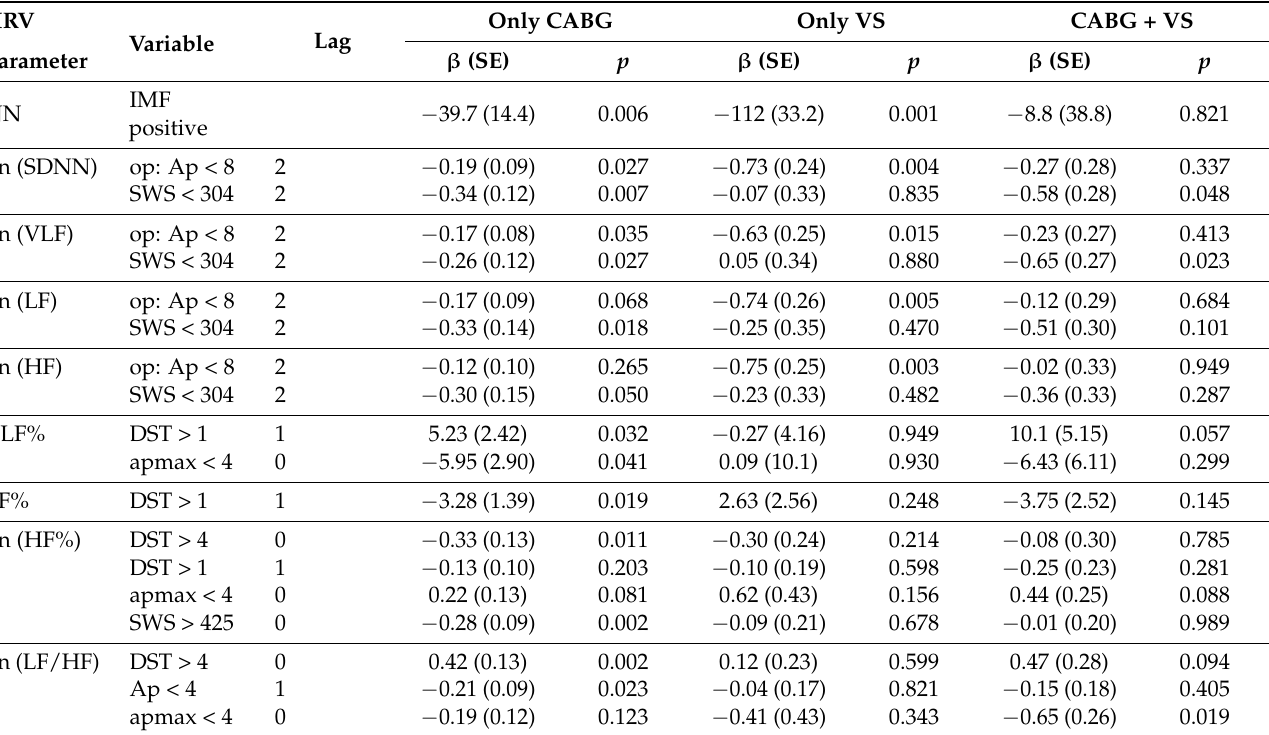
Table 3. Multivariate associations between space weather variables and HRV for different types of